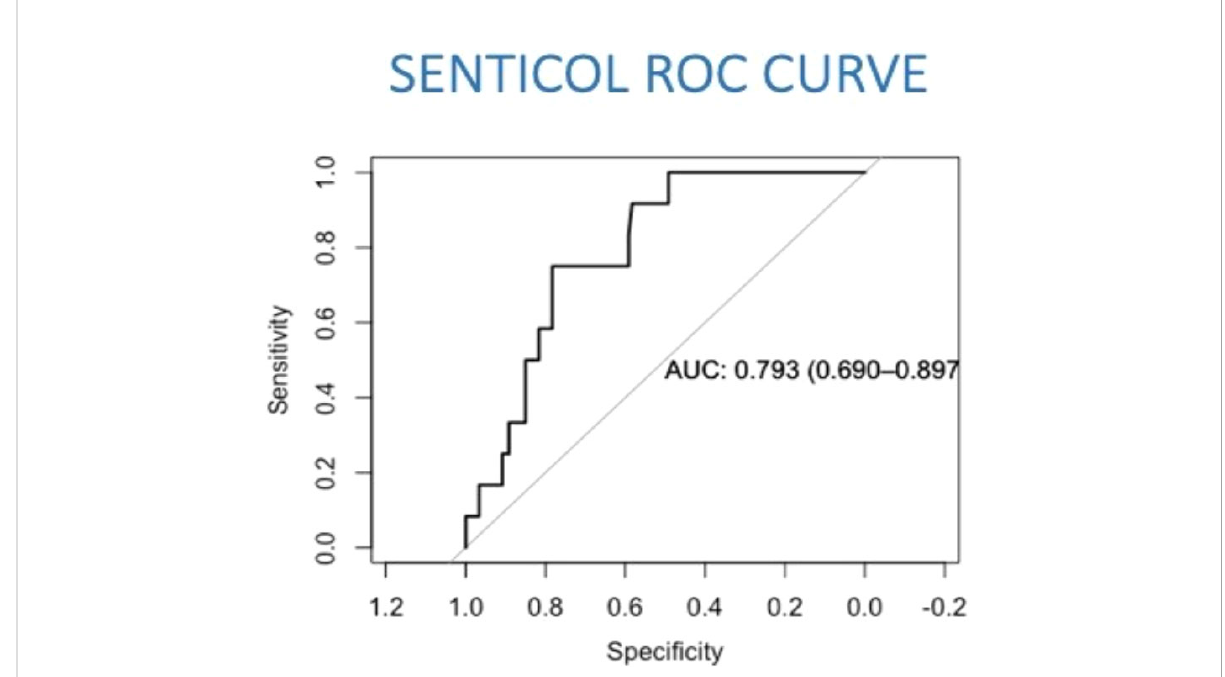
FIGURE 2 Prediction model of lymph nodal invasion in Senticol 1 and 2 patients. AUC, area under the curve; ROC, Receiver Operating